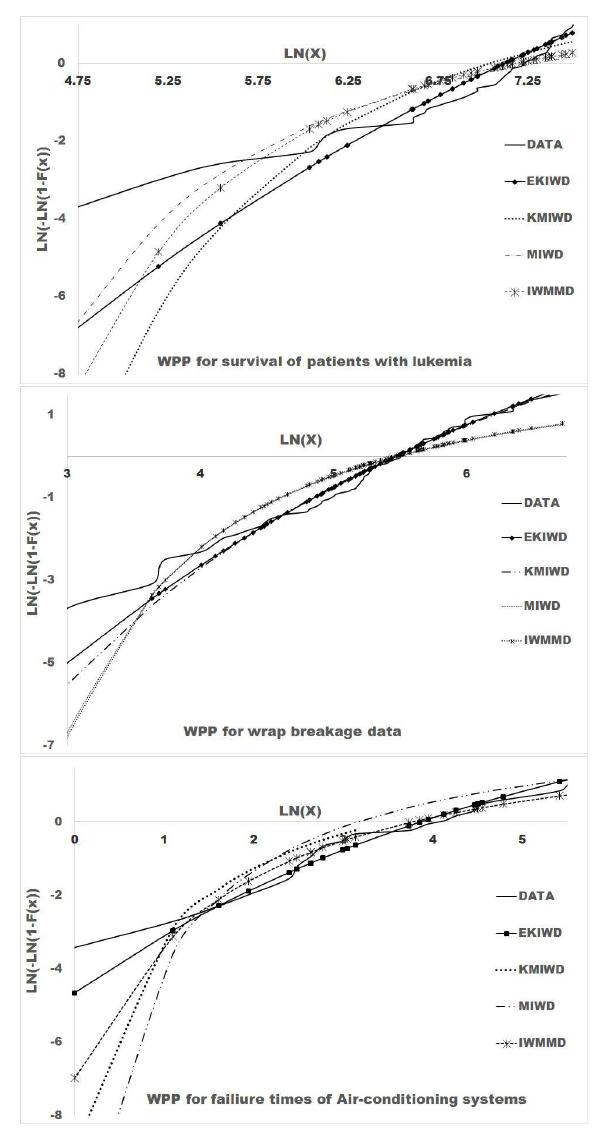
Figure 5 – Weibull probability plots of EKIWD , KMIWD , EMIWD , MIWD , GIWD and IWMM corresponding to data sets 1, 2 and